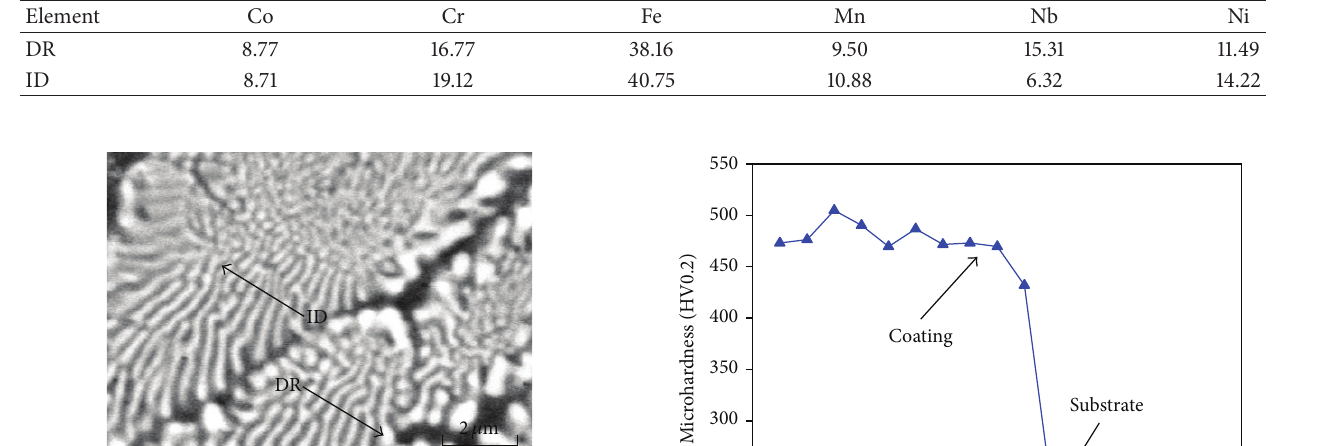
Table 3: Chemical proportion of DR and ID (At. %).